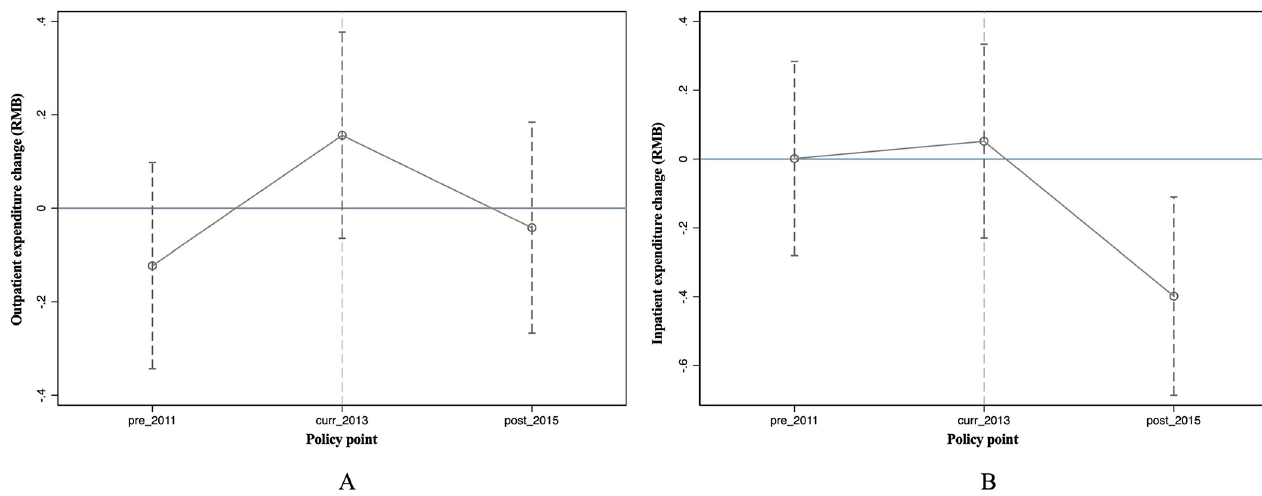
Fig 4. A. Trends in outpatient expenditure after PSM (RMB). B. Trends in inpatient expenditure after PSM (RMB).